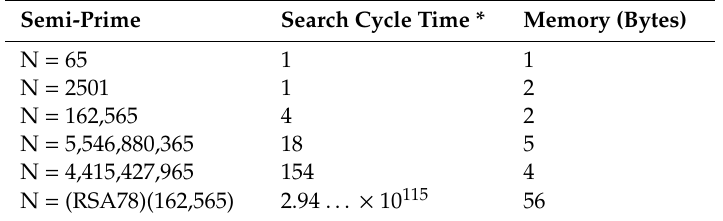
Table 1. A performance comparison of proposed semi-prime factorization for di ff erent lengths. Semi-Prime Search Cycle Time * Memory (Bytes) N = 65 1 1 N = 2501 1 2 N = 162,565 4 2 N = 5,546,880,365 18 5 N = 4,415,427,965 154 4 N = (RSA78)(162,565) 2.94 ... × 10